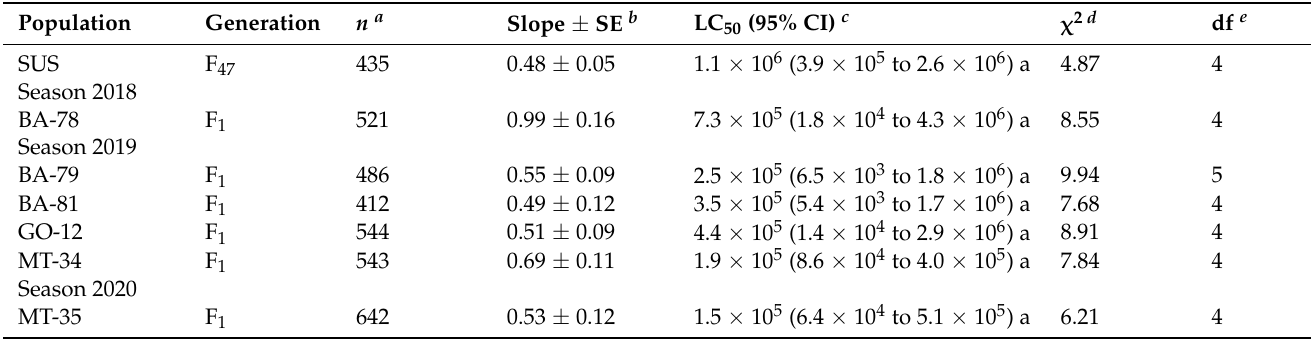
Table 2. Baseline susceptibility of Helicoverpa armigera to HearNPV.